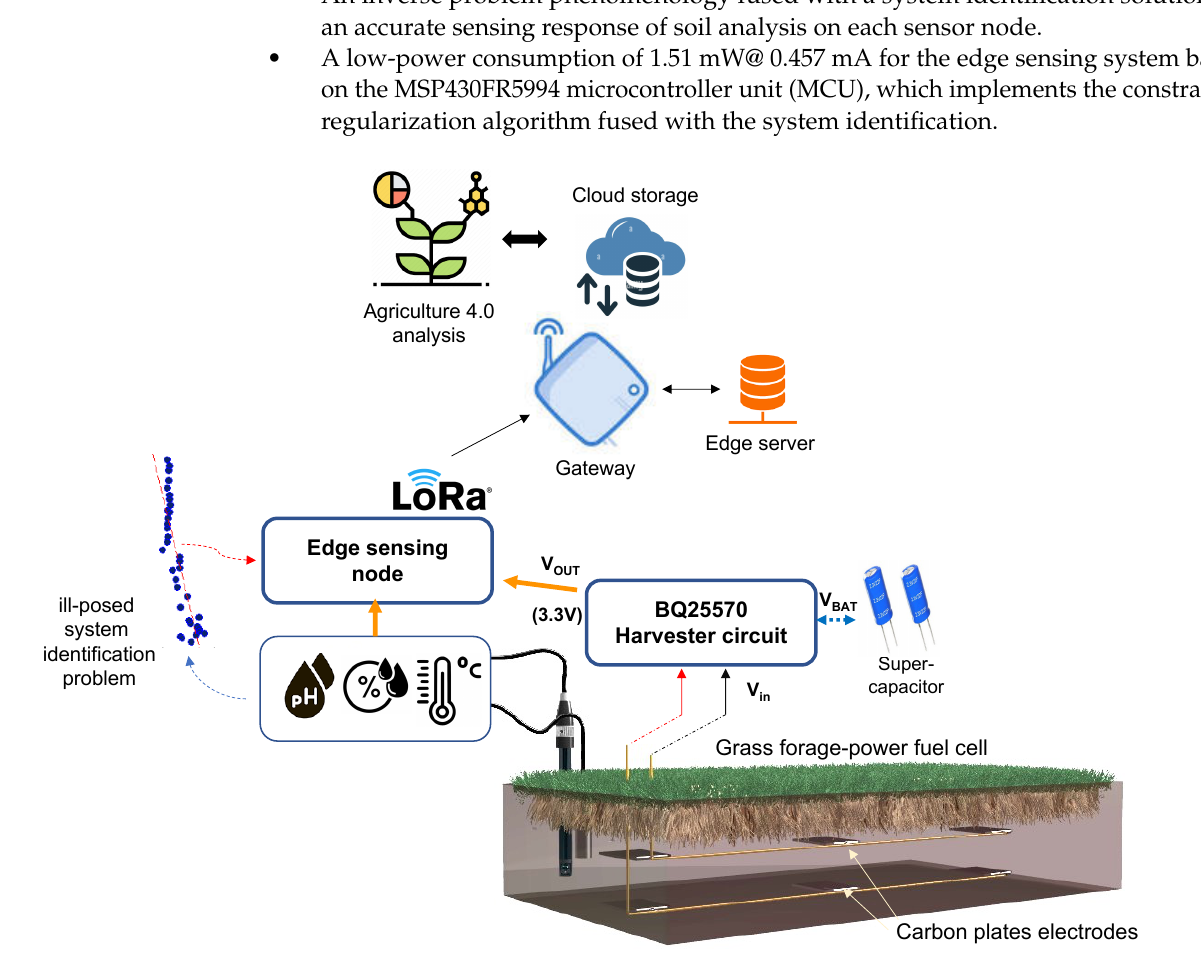
Figure 1. Conceptual idea of the proposed grass forage-power fuel cell for edge-computing wire- less